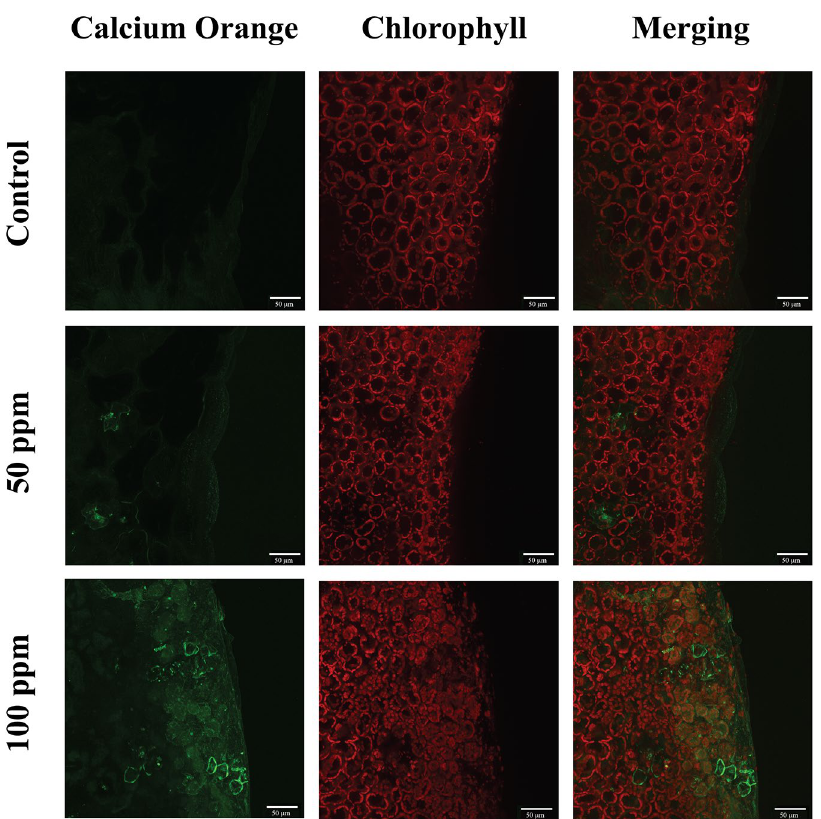
Figure 5. False-colour image analysis reconstructions from confocal laser scanning microscope observations and fluochemical intracellular Ca 2+ determination. The green fluorescence indicates the presence of Ca 2+ in cells, whereas the chloroplasts are shown by a bright red colour caused by chlorophyll fluorescence. Leaves of Brassica nigra were incubated for 20 min with MES buffer + 0.1% Tween 20 as control, and either 50 ppm or 100 ppm of ( Z )-11-16:Ald (diluted in MES buffer + 0.1% Tween 20). Scale bars are indicated on pictures. Exposure to ( Z )- 11-16:Ald increased [Ca 2+ ] in cells exposed to the molecule. n = 2 for each